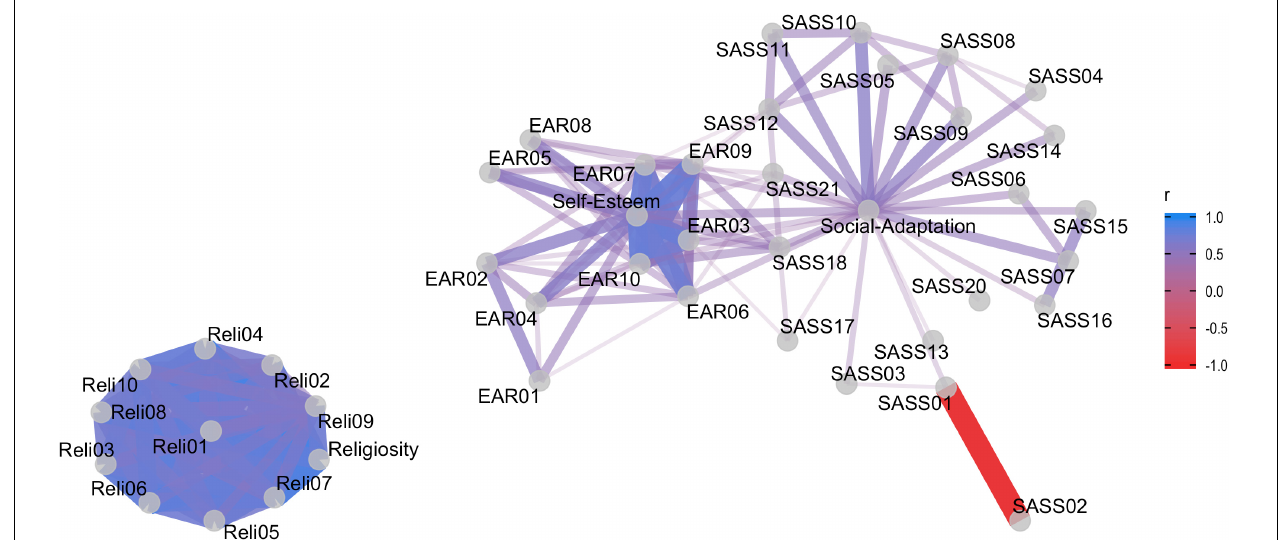
FIGURE 2 | Correlation network among questionnaire items. Pearson’s r correlation between questionnaire items. SASS, Social Adaptation Self-evaluation Scale; EAR, Rosenberg’s Self-Esteem Scale; Reli, Santa Clara’s Religiosity